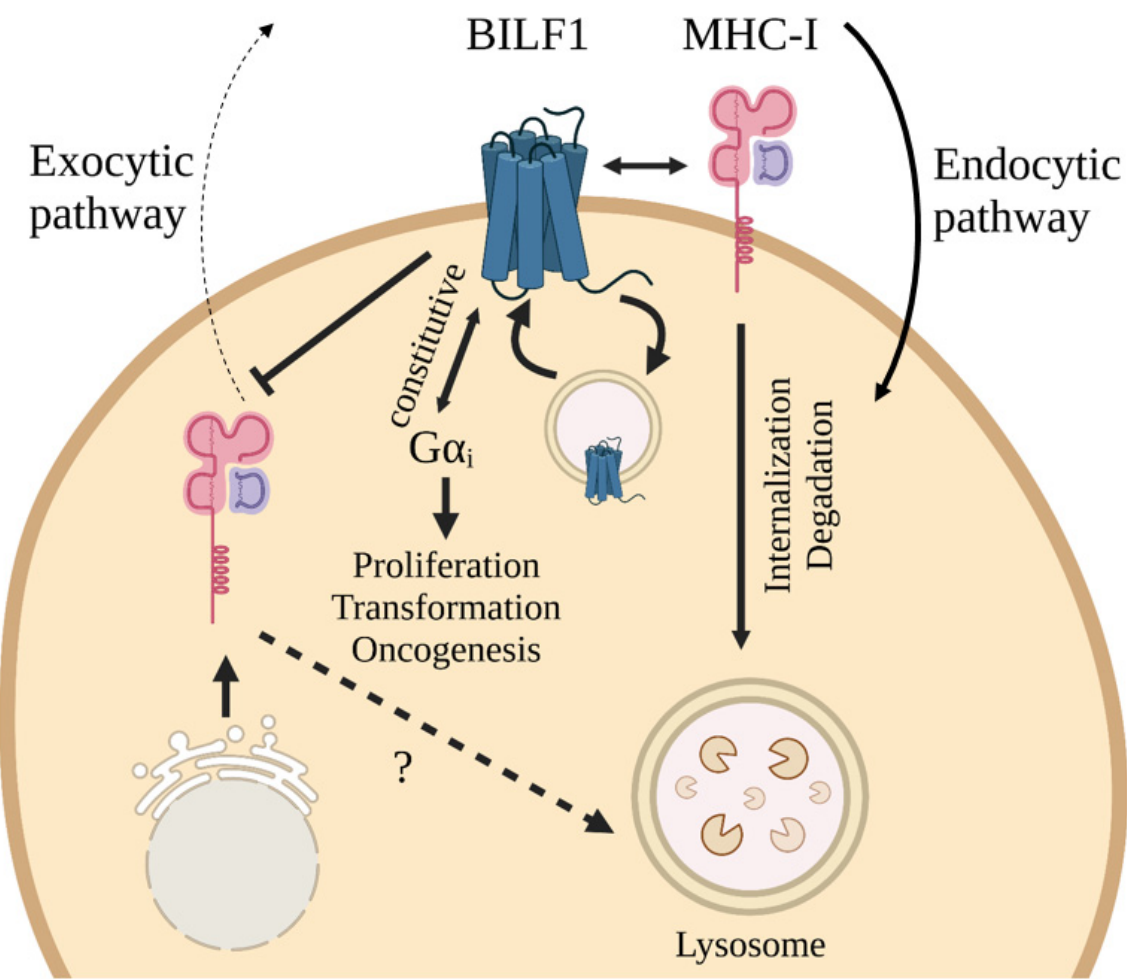
Figure 4. Constitutive signaling and internalization of EBV-BILF1, and its effects on oncogenesis and MHC class I downregulation. In the endocytic pathway, BILF1 physically interacts with MHC-I at the plasma membrane and promotes MHC-I internalization. In the exocytic pathway, BILF1 drives the inhibition of surface expression of newly synthesized MHC-I molecules. Constitutive signaling though G α i results in cell proliferation, transformation and oncogenesis. Created with BioRender.com.